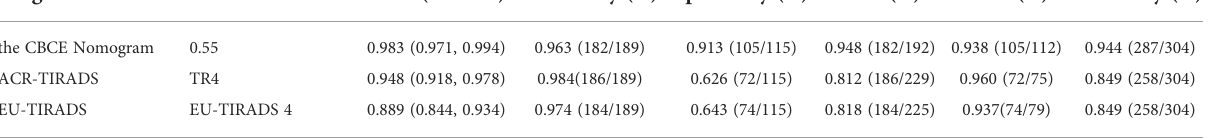
TABLE 4 Diagnostic performances of the CBCE Nomogram, ACR-TIRADS and EU-TIRADS in the validation group.